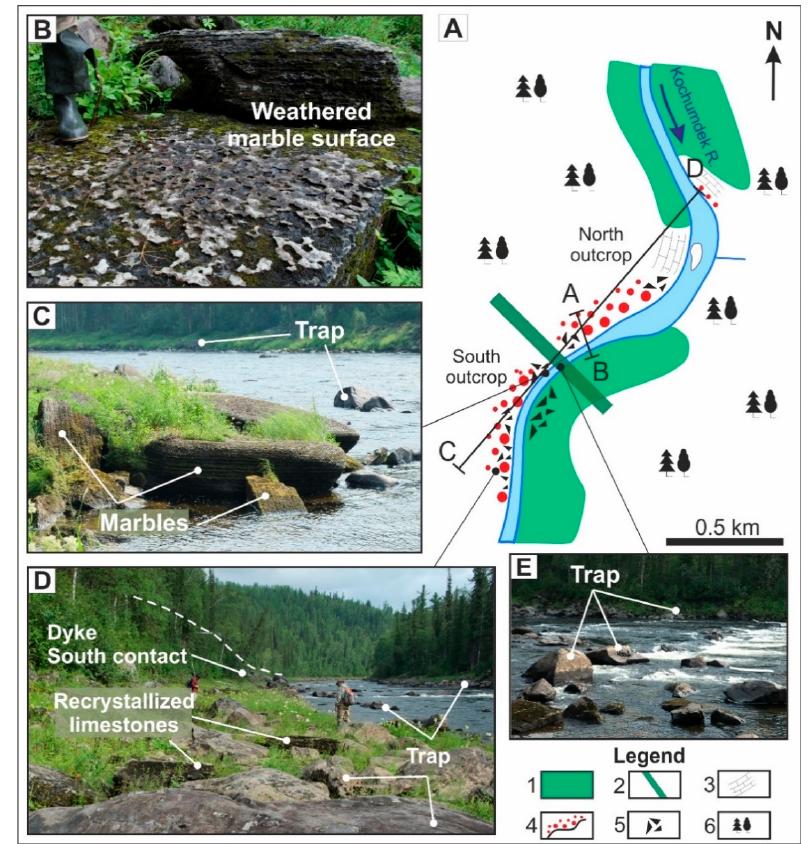
Figure 2. Schematic map of sampling site ( A ) and south outcrop photos ( B–E ) on the right bank of the Kochumdek River (2017). ( B) Weathered marble surface. ( C ) Scattered blocks of tilleyite and wollastonite marbles. ( D) Panoramic photo of right bank of the Kochumdek river floodplain (from south to north). Scattered blocks of recrystallized marly limestones and low-grade marbles from south contact. The rapids in the background of the Kochumdek River consist of gabbro ( E ). Cross sections along lines A-B and C-D see at Figure 4. 1 = Kochumdek trap, 2 = Dyke, 3 = Recrystallized marly limestones of the Lower Kochumdek Subformation, 4 = Marbles (large and small circles are high- and low-temperature rocks), 5 = Scattered rock blocks, 6 = Taiga.